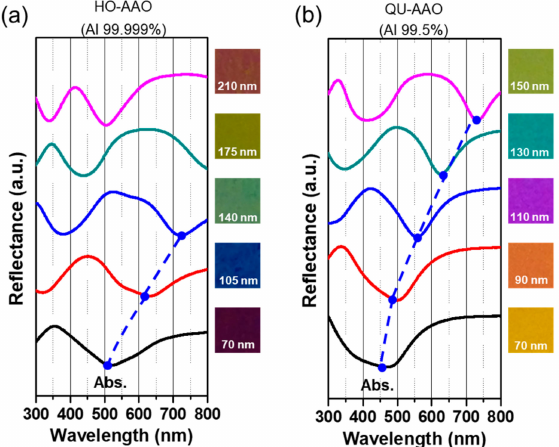
Figure 4. OpticalreflectancespectraofAu-coated( a )HO-AAOand( b )QU-AAOplasmonicnanostructures in visible wavelength range. The spectrum is plotted with respect to the thickness of the alumina layer. The graphs are shifted in the y -axis for clarity according to the alumina thickness. The optical images show the evolution of the sample color. Both AAO plasmonic nanostructures display very similar optical responses, except that the locations of the absorption band are off by 50–100 nm for the samples with the same